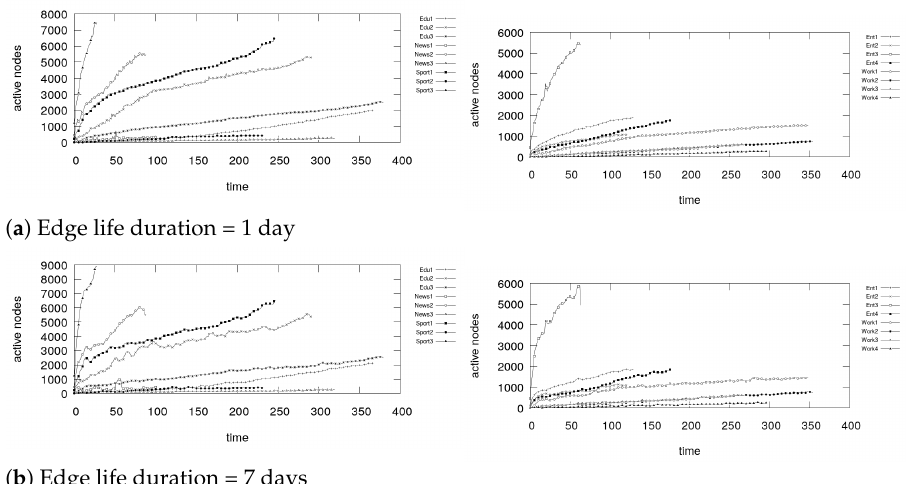
Figure 12. Number of active nodes detected by Infomap.